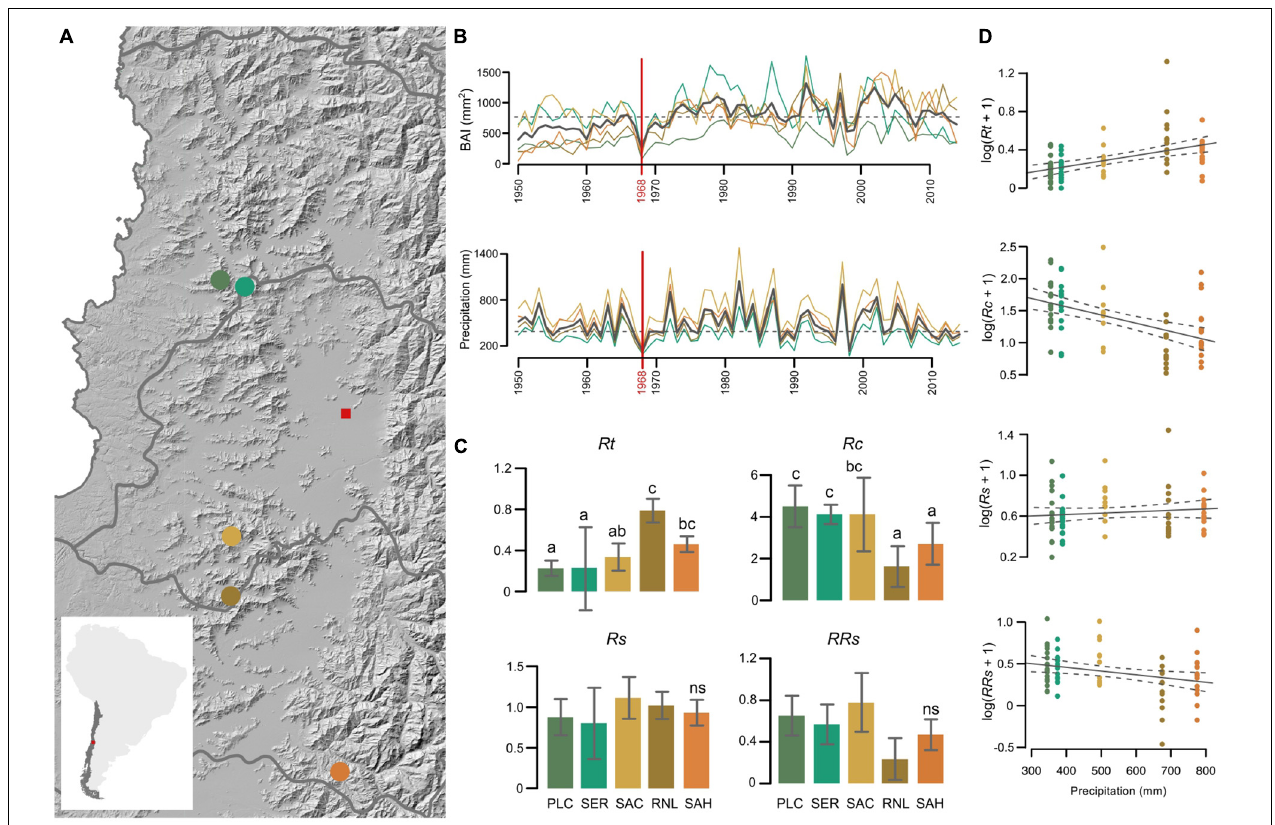
FIGURE 1 | (A) Study area of five studied N. macrocarpa population (red is Santiago city). (B) BAI series of N. macrocarpa and annual total precipitation series by five sites for period 1950–2014. (C) Mean (bars) and SEM (segments) for the resilience components at each study site; Rt: Resistance, Rc: recovery, Rs: resilience, RRs: relative resilience. Different letters indicate significant difference between sites at 95% confidence level, while “ns” is not significative. (D) Relationship between precipitation and resilient components of N. macrocarpa five